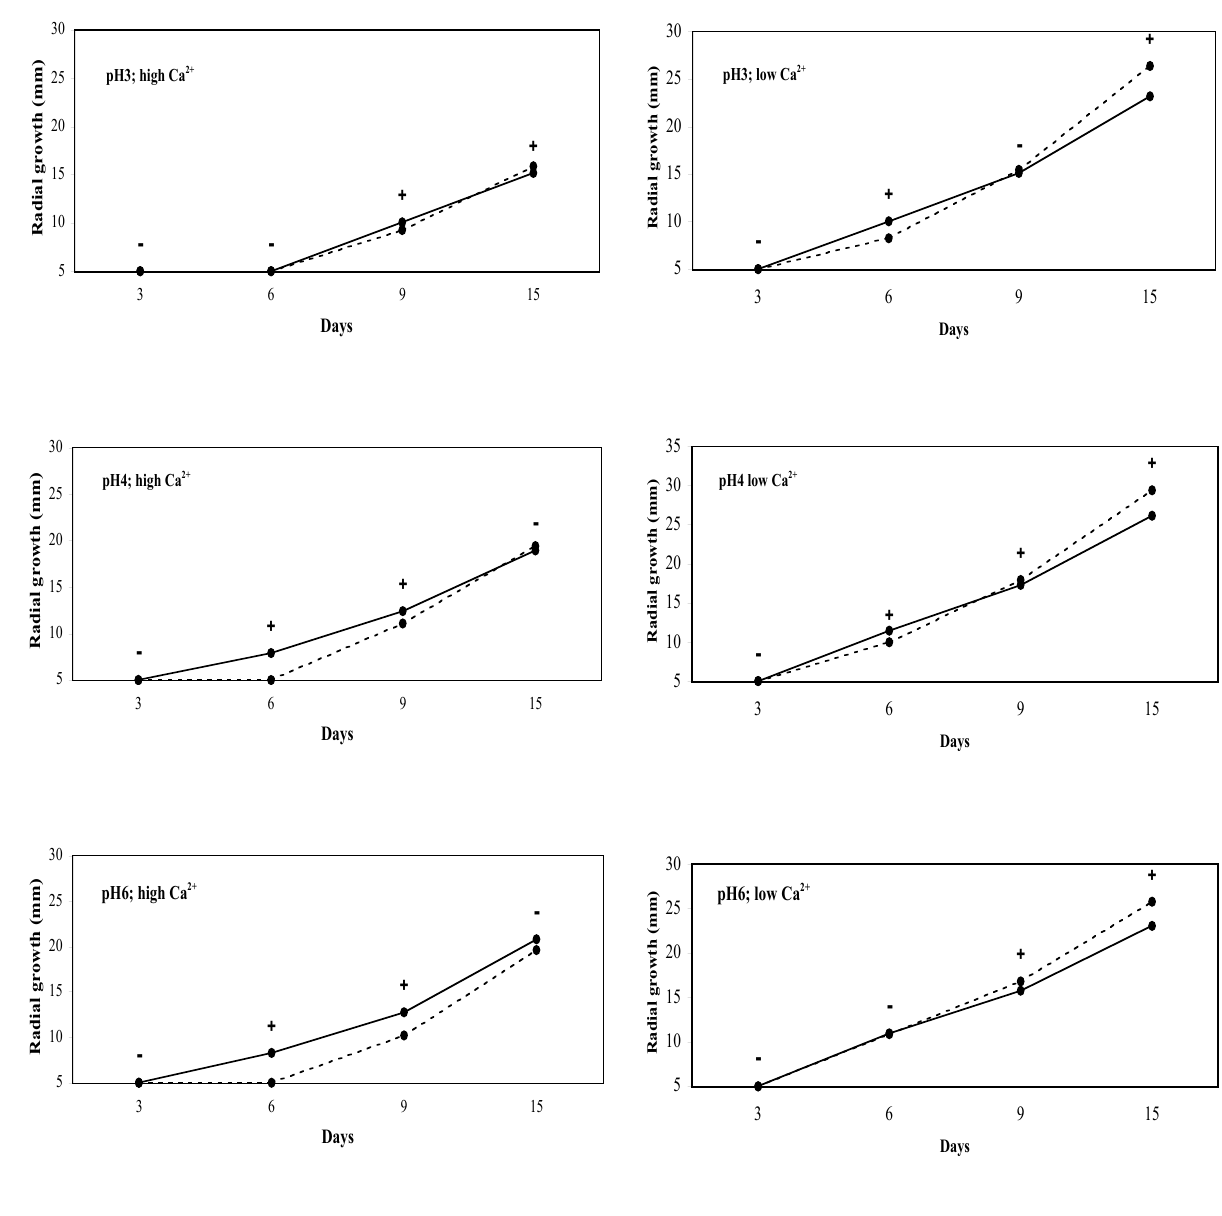
Fig. 4. Differential colony growth of Phaemoniella chlamydospora isolate 16 (- -) and 52 (—) on plates containig EPA with pectin as sole carbon source, under the effect of different pH values and higher or lower calcium ions concen- tration of the media. Mean results of 6 plates. SE < ± 0.7 mm. For each time point the observed differences between the two Pch isolates grown in the same condition of pH and calcium level of the media, were evaluated with Stu- dent’s t test. Significative differences ( P < 0.01; two tails distribution) are reported on the chart with a “+”